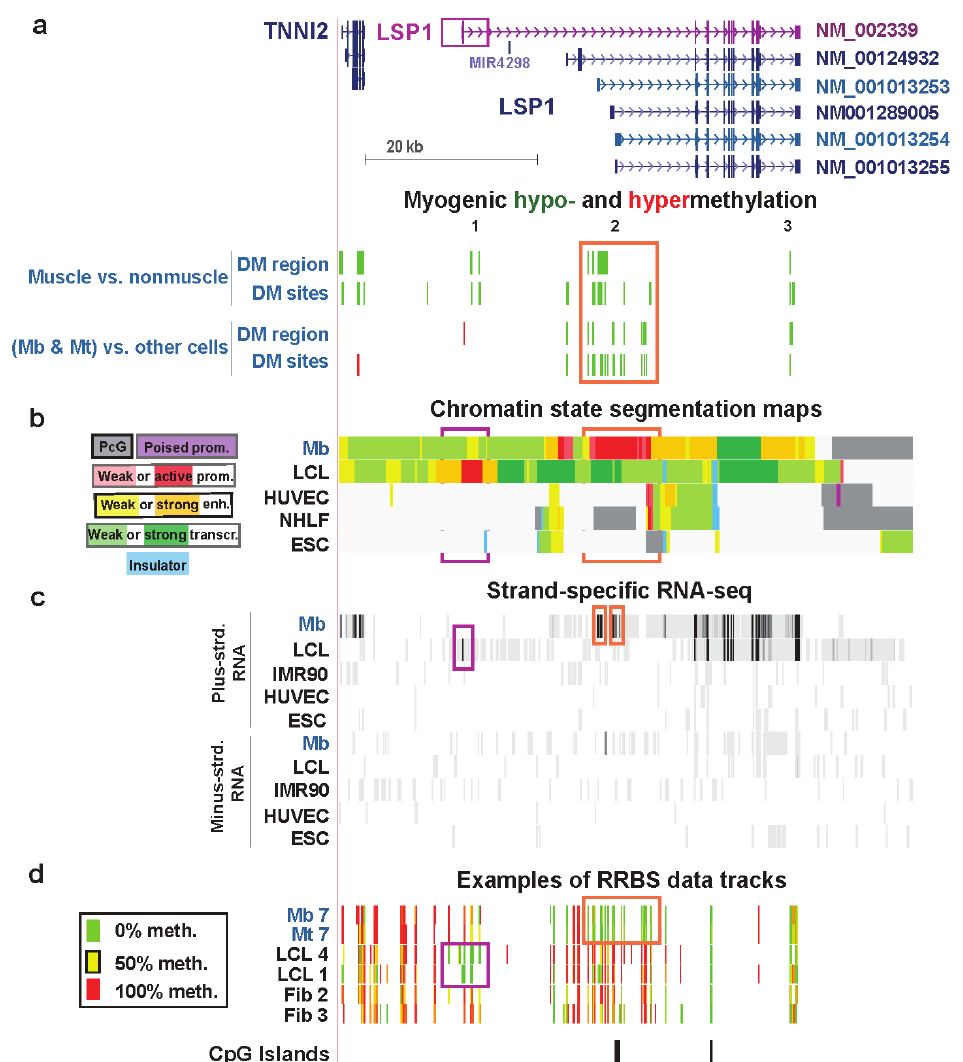
Figure 8. Myogenic hypomethylation vs . lymphoid hypomethylation at tissue-specific promoters of LSP1 . ( a ) The main RefSeq isoforms detected in Mb and lymphoid cells are shown in blue-green and purple, respectively (chr11:1,859,948-1,926,584). Myogenic differential methylation is indicated as described for Figure 6. ( b ) Chromatin states are depicted as in previous figures. ( c ) Strand-specific RNA-seq data are shown for both strands with the vertical viewing range set at 1-to-100. The narrow orange rectangles indicate signal from alternative first exons of LSP1 in Mb. The narrow purple rectangle marks the first LCL exon. In other tracks similar regions are boxed. Previously we concluded that the main LSP1 transcript in Mb was ENST00000405957 [10], which is very similar to RefSeq transcript NM_001013253. However, new RNA-seq profiles (G. Crawford and M. Ehrlich labs [16]), which had greater depth of cDNA sequences for LSP1 and used different Mb samples, indicate that NM_001013254 was the major LSP1 transcript in three of four Mb or Mt samples and NM_001013253 was the major transcript in the fourth sample (Table S1); however, the multiplicity of LSP1 isoforms complicates their resolution (see text). ( d ) Examples of RRBS data tracks for several of the myogenic progenitor cell, lymphoblastoid cell, and skin fibroblast